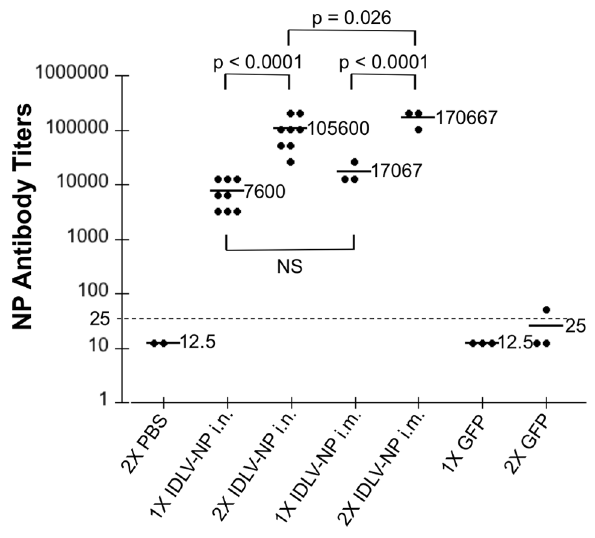
Figure 5. Immunization with IDLV-NP induces NP-specific IgG responses that are increased upon boosting. Mice were inoculated 2 times i.n. or i.m. with IDLV-NP, 4 weeks apart. Mice that received either PBS or IDLV-GFP 1 or 2 times i.n. served as a negative control. Serum was collected from each mouse prior to the first immunization, prior to the second immunization (1X), and 4 weeks after the second immunization (2X). NP-specific IgG in serially-diluted serum samples was measured by indirect ELISA assay and is expressed as endpoint titers, defined using the pre-immunization sera as a baseline. Each dot in the panel represents one mouse, and bold lines indicate the mean. The lower limit of detection is indicated by the dotted line. The Kruskal-Wallis test was used to compare antibody titers between the groups (overall p-value of , 0.0001). P-values from pairwise group comparisons based on the ANOVA test are